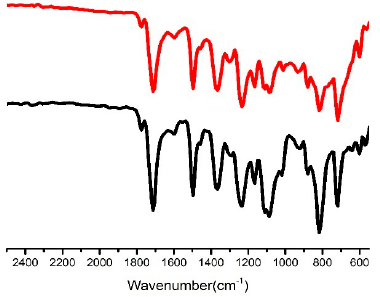
Figure 11. Infrared (IR) spectra of the original polyimide (PI) surface (lower black line) and the PI surface with the plasma discharge (upper red line), showing no structural change after the plasma discharge.